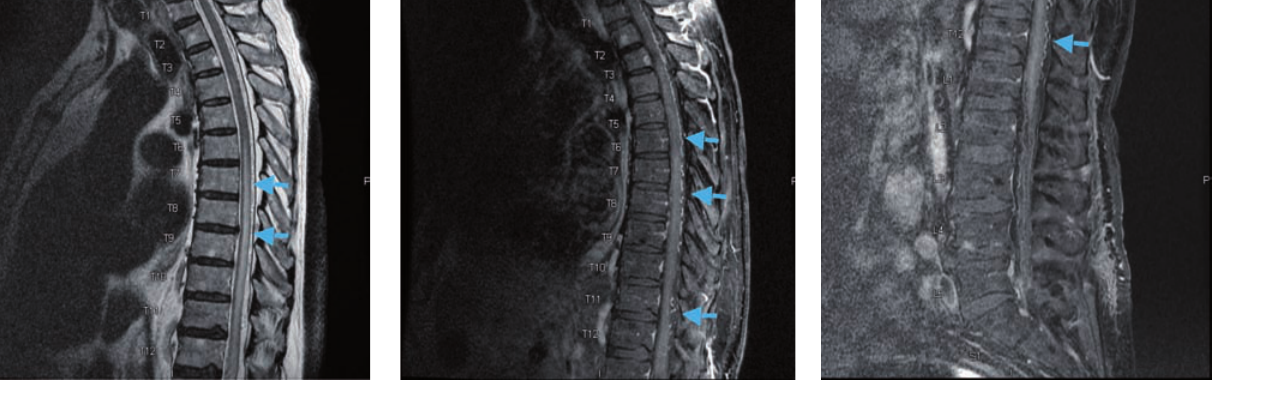
Figure 3. Sagittal T1 FAT saturated sequence post-contrast shows prominent tortuous intradural veins from level T11- 12 down to the cauda equina nerve roots (arrow)